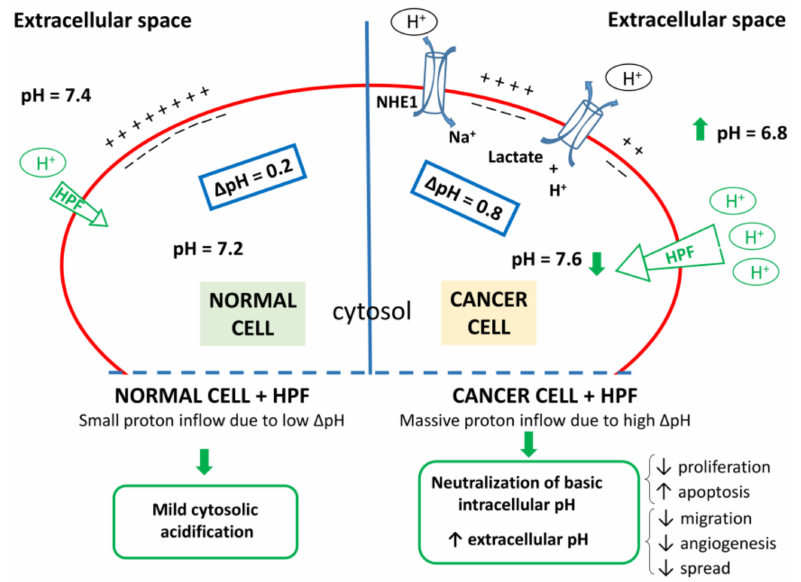
Figure 3. Proton dynamics in normal and cancer cells. Left: normal cells display mild difference in proton concentration between extracellular space and cytosol ( ∆ pH~0.2). Right: Differently from normal cells, cancer cells show high activity of a number of channels that regulate pH (NHE; Hv; V-H + /ATPase; Na + /HCO 3 − cotransporter; H + /K + -ATPase and H + /lactate cotransporter, two of them being represented as examples), which results in increase of proton concentration in the extracellular space combined with cytosol alkalization ( ∆ pH~0.8). In the presence of HPF, due to the protonophore activity of this compound, proton conductance increases. In both cell types exposed to HPF, the negative charges of the cytosolic side of plasma membrane foster a proton influx, which is small in normal cells and large in cancer cells displaying higher ∆ pH. Thus, cancer cells exposed to HPF can import a larger amount of protons which counteracts intracellular alkalization and extracellular acidification, both hallmarks of malignancy. Green arrows and outlines refer to the putative effects of